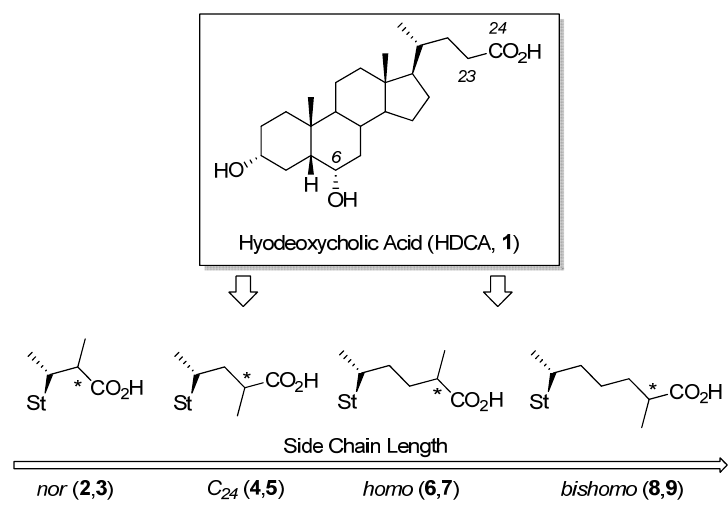
Figure 1. Synthesis of HDCA Derivatives 2 – 9 .